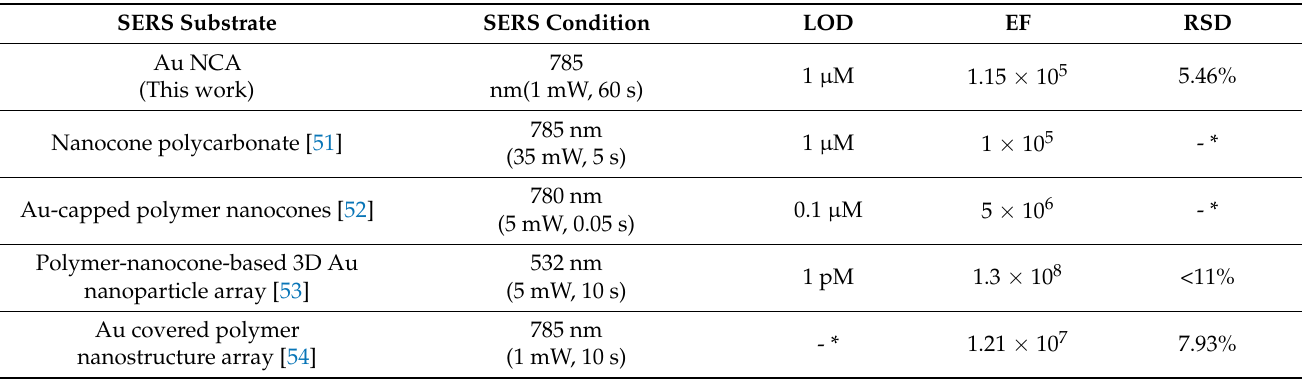
Figure 6. ( a ) SERS spectra of 4-MBA (10 − 3 M) randomly collected at 60 sites from three Au NCA substrates; ( b ) spot-to-spot intensity distribution at 1080 and 1594 cm − 1 (left and right, respectively. the average intensity is indicated by the red line, and the light-yellow zones represent the ± RSD; ( c ) substrate-to-substrate intensity distribution at 1080 and 1594 cm − 1 . Table 1. Comparison of the limit of detection (LOD), enhancement factor (EF), and reproducibility (RSD) for different nanocone SERS substrates fabricated by